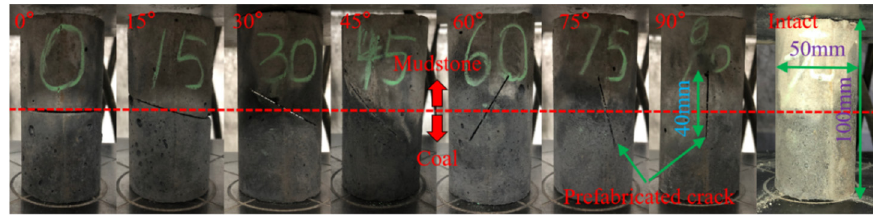
Figure 1. Coal–mudstone specimens with different prefabricated crack angles. Table 1. Physical and mechanical parameters of coal and mudstone